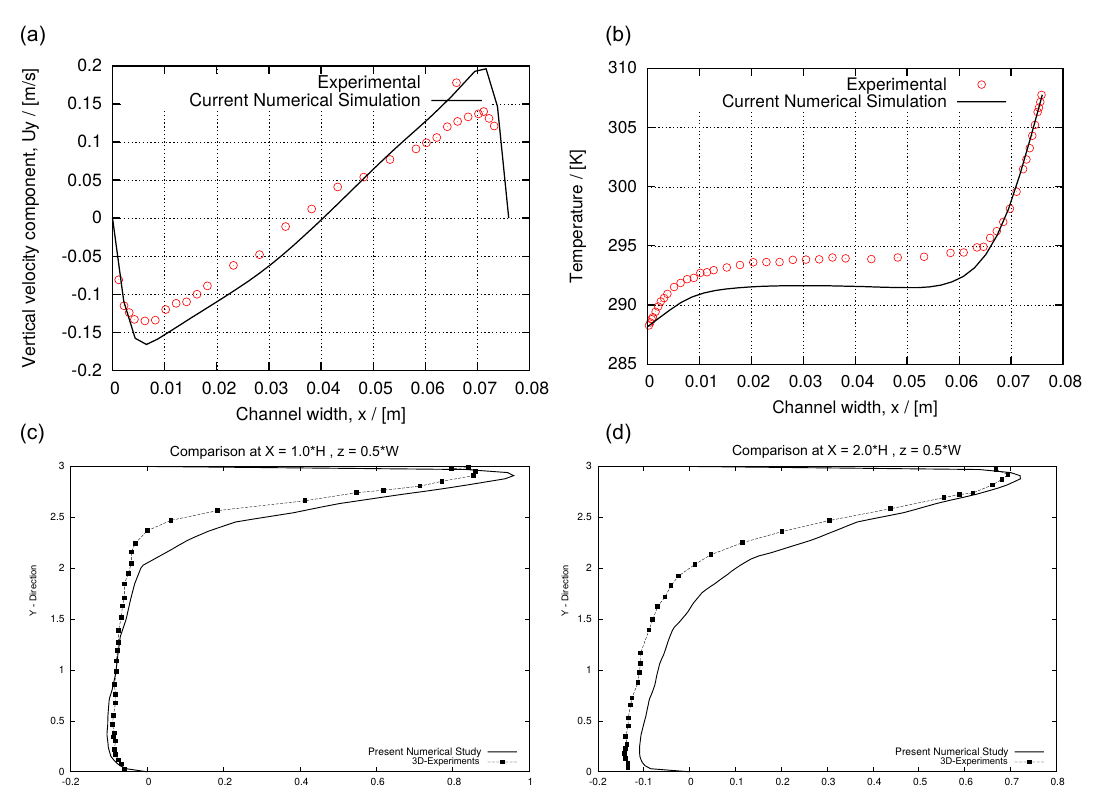
Figure A1. ( a , b ) Vertical velocity profile and temperature profile for the long cavity along X axis as discussed in [54]. ( c , d ) Normalized velocity profile for the two dimensional model along Y axis for X = 1 × H and X = 2 × H is shown.